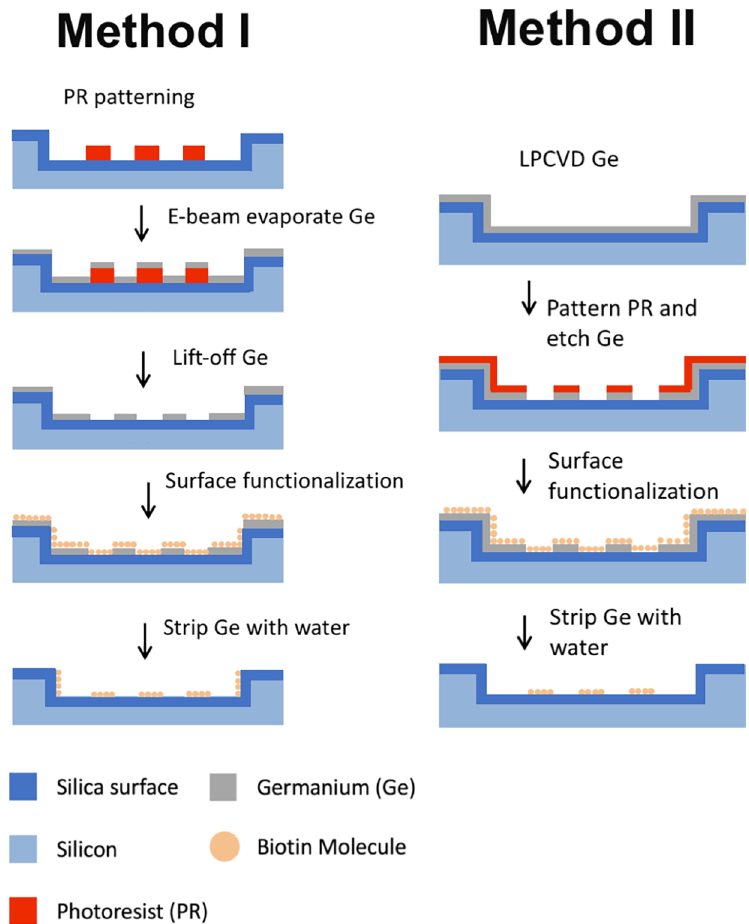
Fig 1. Fabrication process overview. Left) 50 nm Ge layer is patterned with E-beam evaporation and a lift-off process. Vertical sidewalls are functionalized along with horizontal openings. Right) 50 nm Ge layer is patterned with LPCVD and etching. Vertical sidewalls are completely covered and not exposed to functionalization solution. After Ge patterning and surface chemistry, Ge layer is dissolved in 0.35% H 2 O 2 and the chip is ready to use.